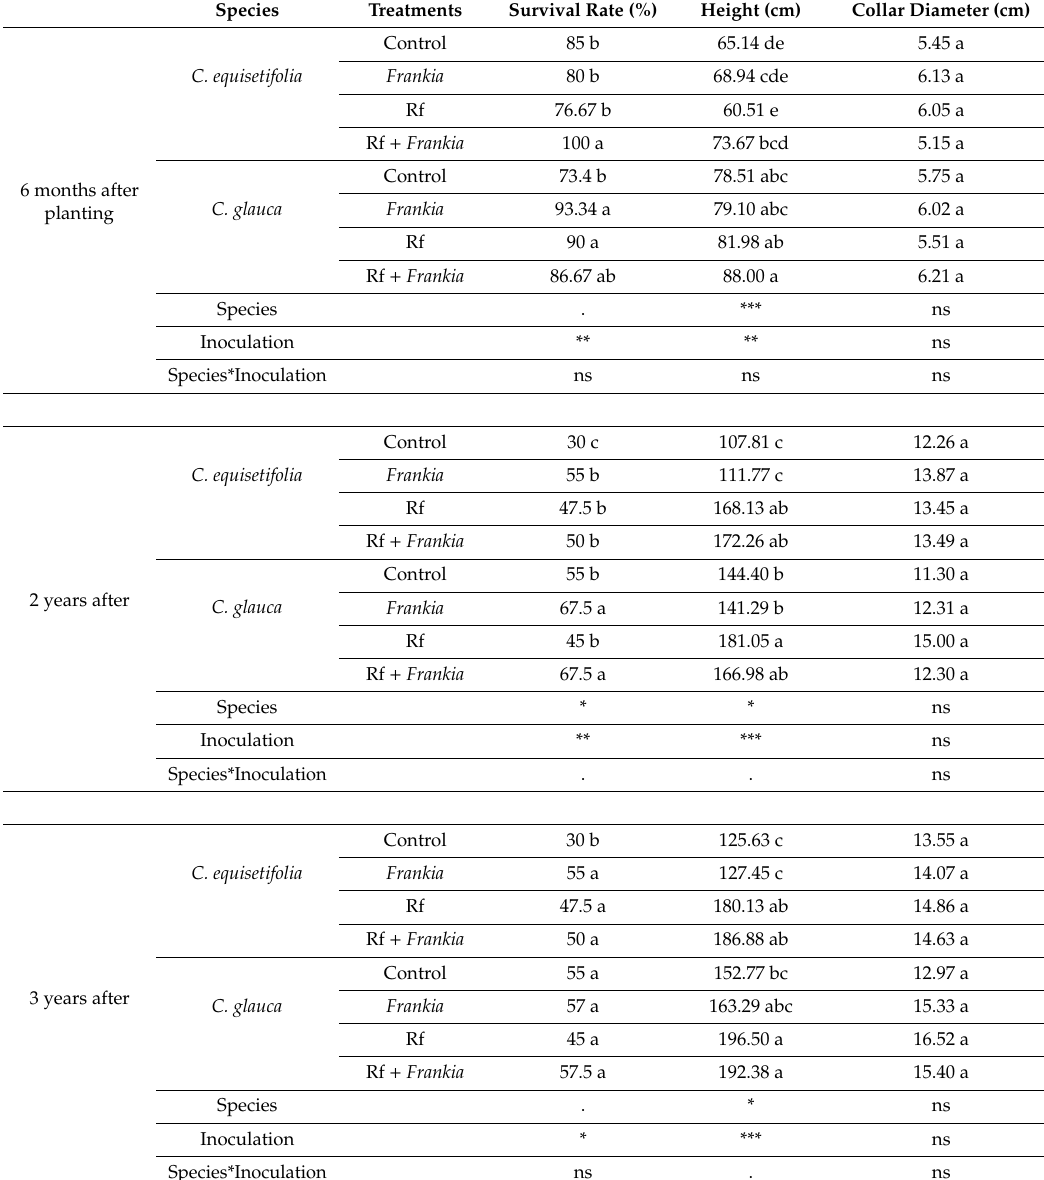
Table 2. E ff ect of inoculation with R. fasciculatus and Frankia on the survival rate and height of C. equisetifolia and C. glauca plants under saline stress conditions 6 months, 2 years, and 3 years after planting. Control, Rf: R. fasciculatus , Frankia: Frankia strain CeD, and Rf + Frankia : AMF / Frankia co-inoculation. Lower-case letters (a–e) indicate significant di ff erences between control and inoculated plants for each time (6 months, 2 years, and 3